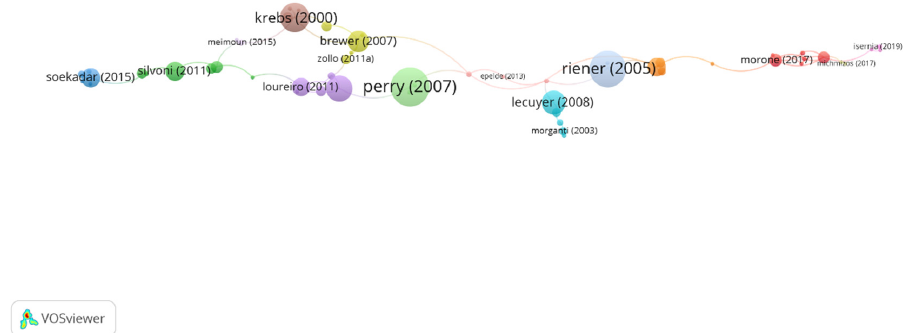
Figure 5. Group 2 citation network. The most cited publication is that of Perry (2007).